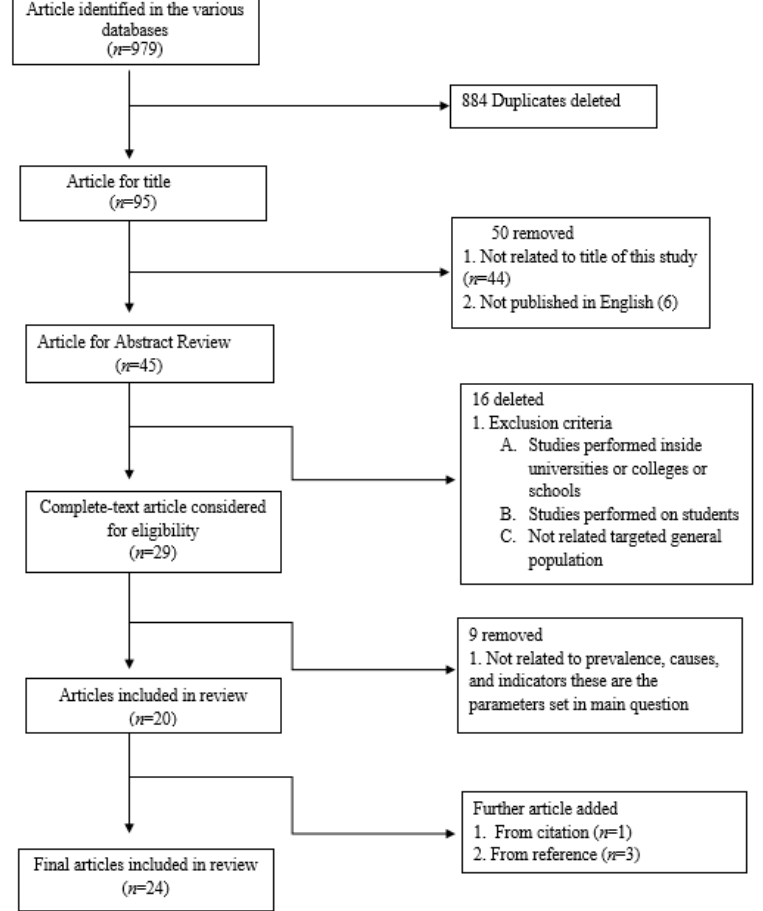
Figure 1. Flow diagram of study selection.